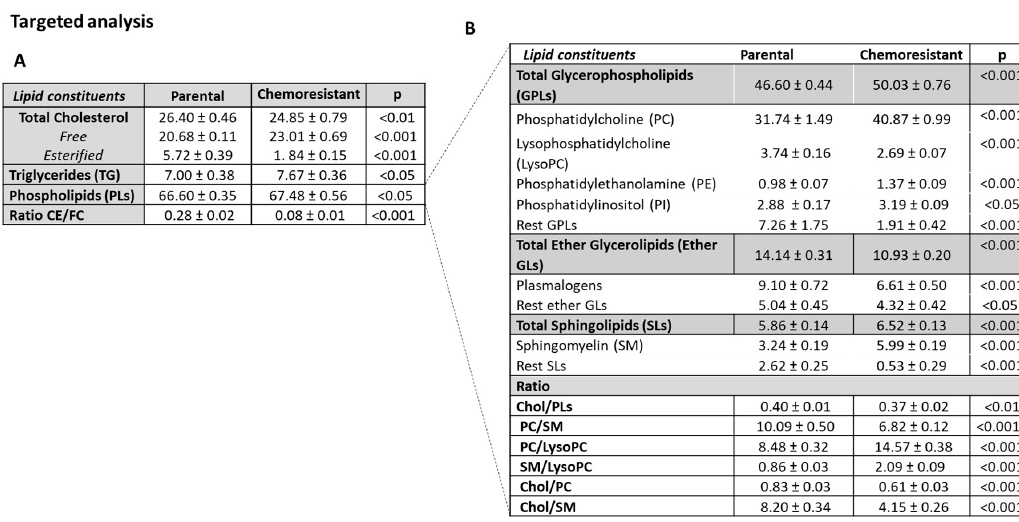
Figure 9. NMR-based compositional characteristics of ( A ) the major cellular membrane lipid classes and ( B ) phospholipids in PTX-res cells and parental cells. Values are expressed in percentages of total lipids (mol/100 mol of Total Lipid Content) and are means ± SD. Abbreviations: CE, Cholesterol Esters; DHA, Docosahexaenoic acid; EPA + AA, Eicosapentaenoic and Arachidonic acid; FA acyl chain, Fatty acid acyl chain, FC, Free cholesterol; LA, Linoleic acid; LysoPC, Lysophosphatidylcholine; PC, Phosphatidylcholine; PLs, Phospholipids; PUFA, Polyunsaturated fatty acids; SFA, Satu- rated fatty acids; SLs, Sphingolipids; SM, Sphingomyelin; TG, Triglycerides; UFA, Unsaturated fatty acids.